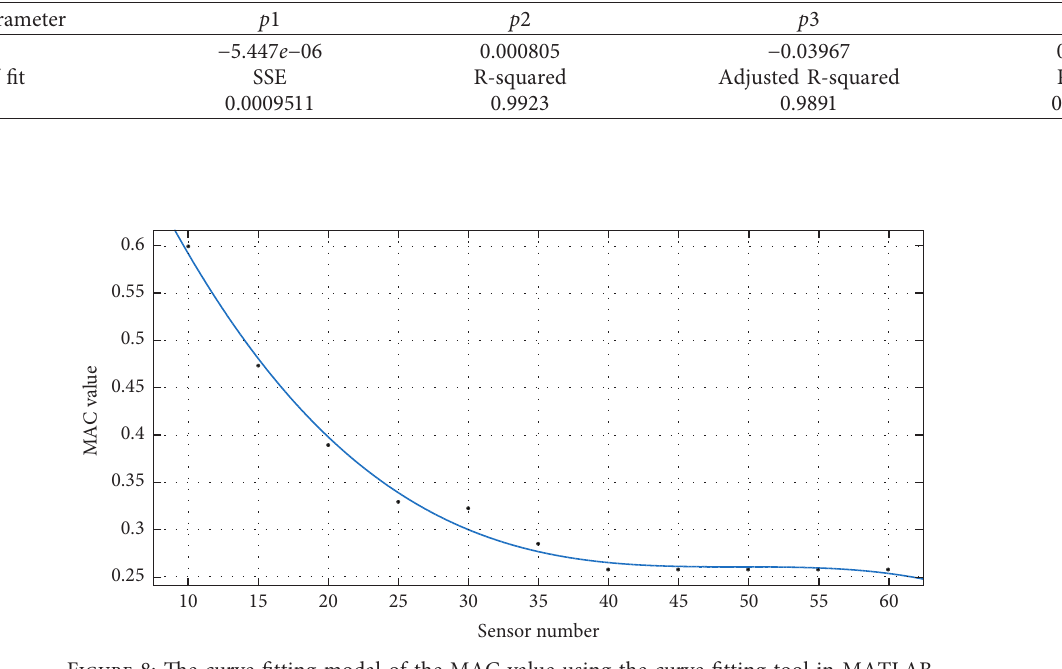
Figure 8: The curve fitting modal of the MAC value using the curve fitting tool in MATLAB.